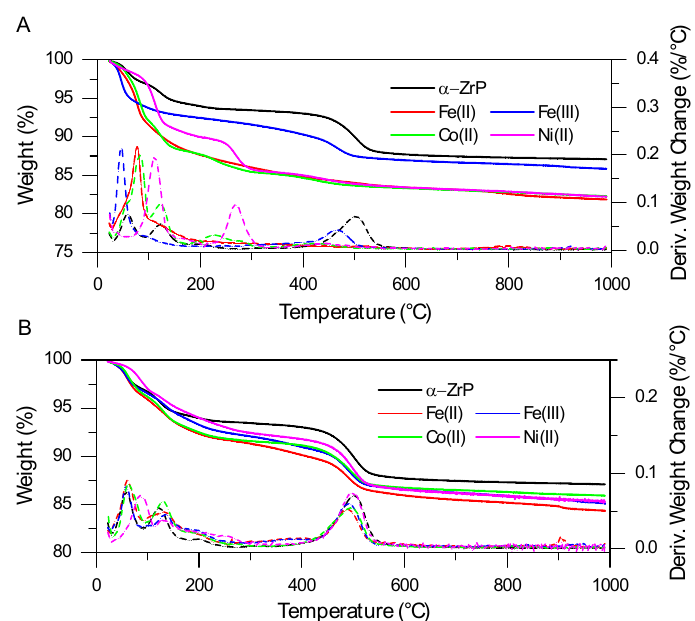
Figure 3. TGA thermograms of ( A ) intercalated and ( B ) adsorbed Fe(II), Fe(III), Co(II), and Ni(II) at a 10:1 M:ZrP ratio. Solid lines and dashed lines correspond to normalized weight and the first derivative of weight change with respect to temperature, respectively.